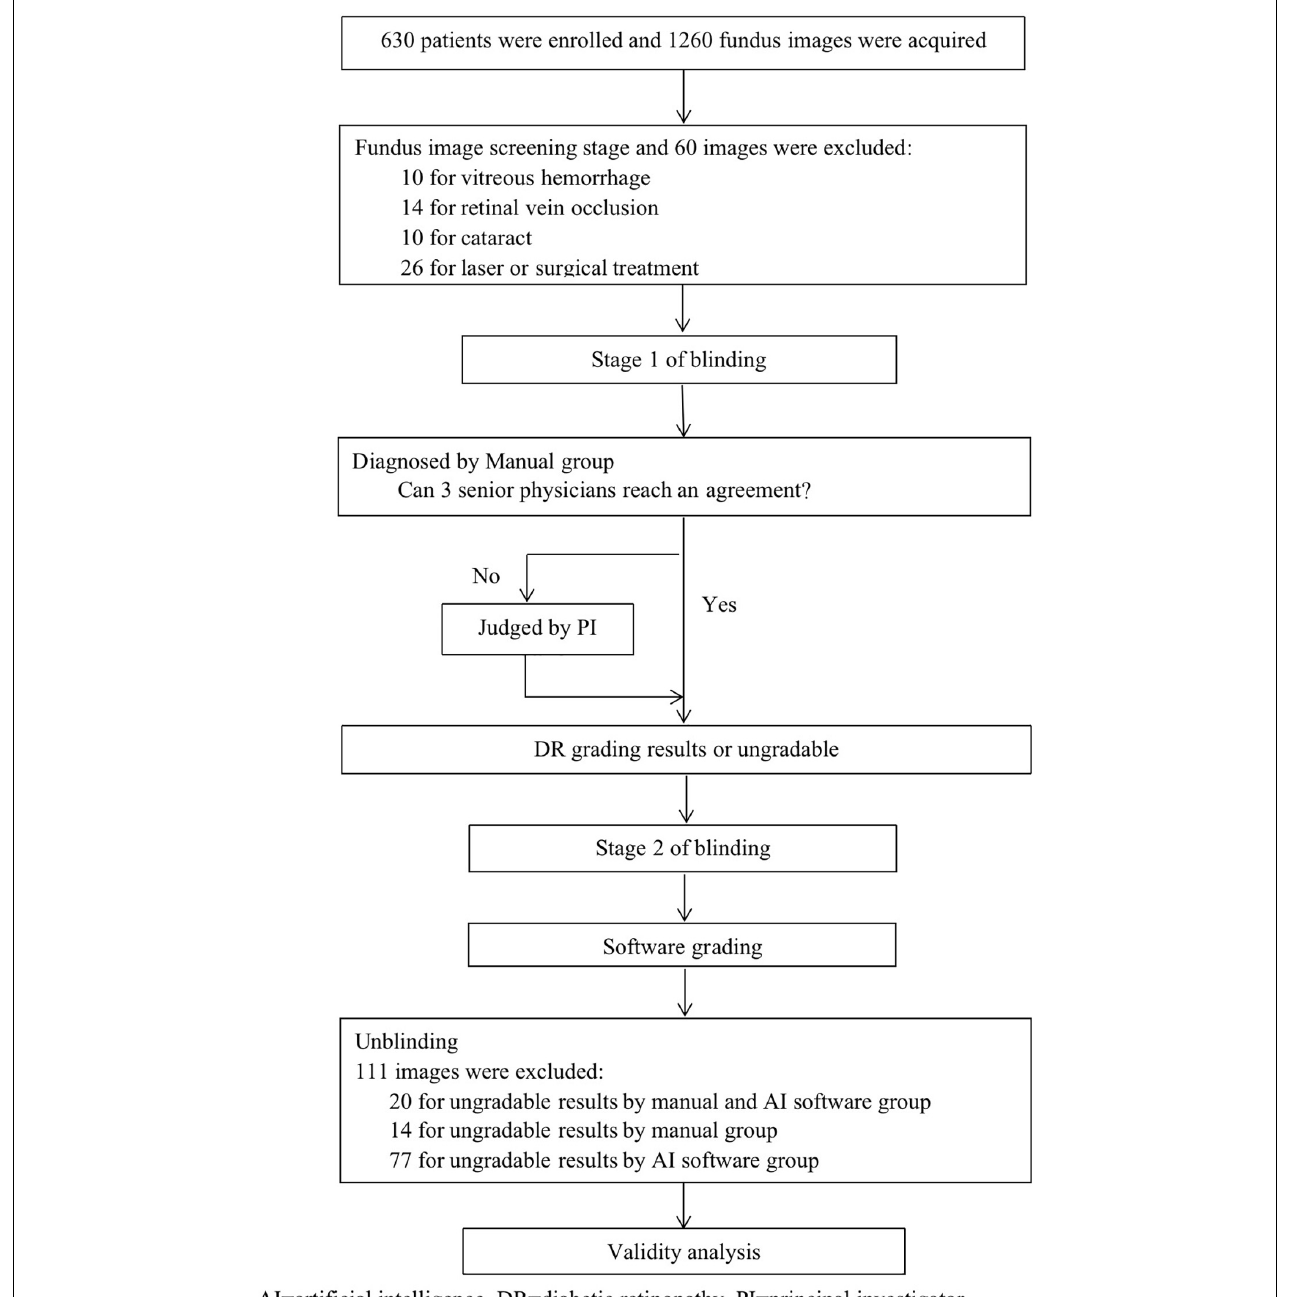
FIGURE 2 | The work flowchart of fundus image